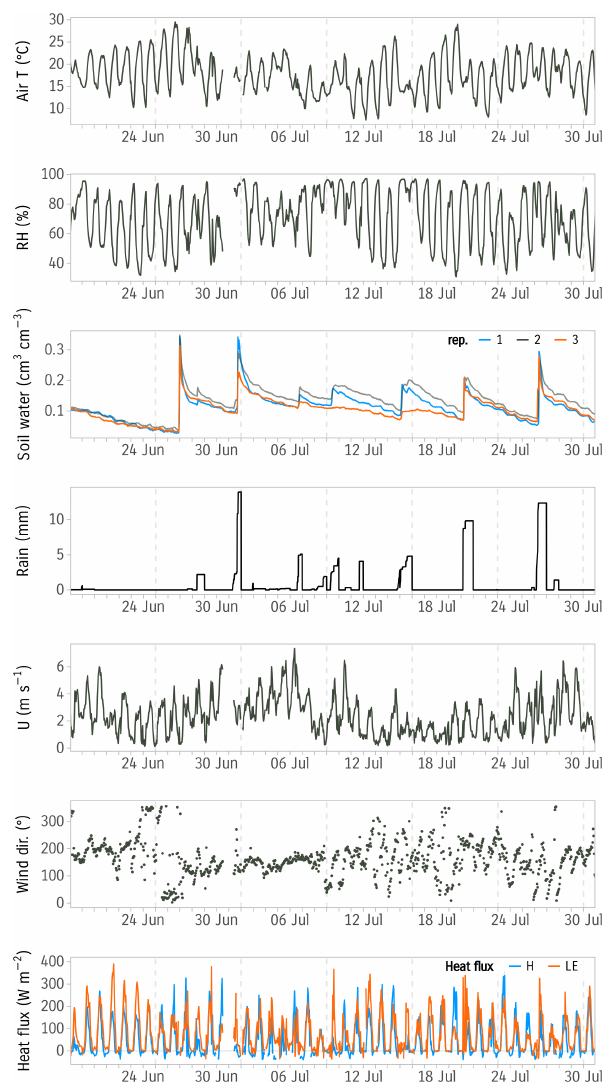
Figure 3. Meteorological conditions and turbulent energy fluxes during the experiment period from 18 June to 31 July 2020: air temperature, relative humidity, soil water content, cumulative daily precipitation, wind velocity, wind direction, sensible heat flux ( H ), and latent heat flux (LE). Precipitation data were obtained from the German weather service (DWD) station in Braunschweig (number: 00662), which is located 600m from the measurement